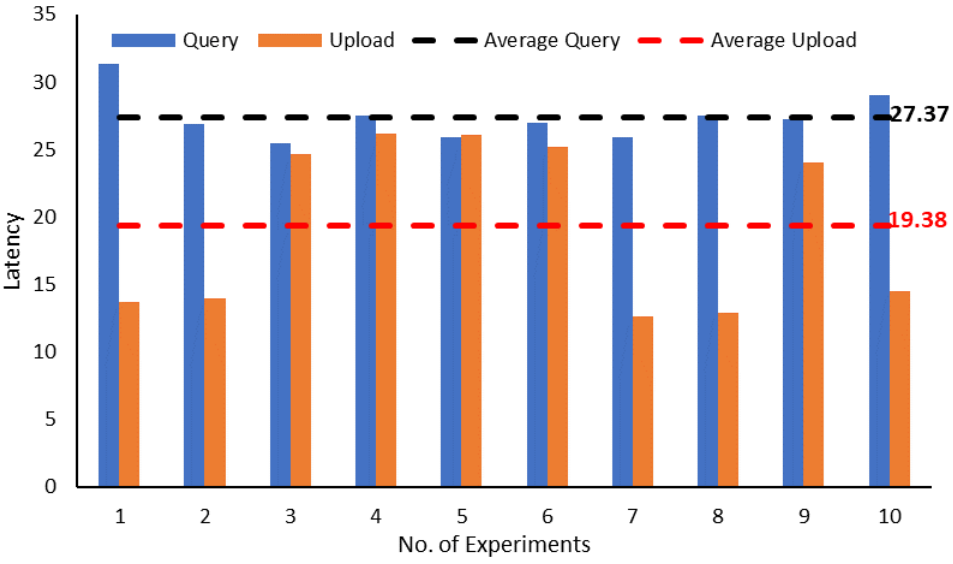
Figure 12. The results of the round-trip time latency in 10 tests for the